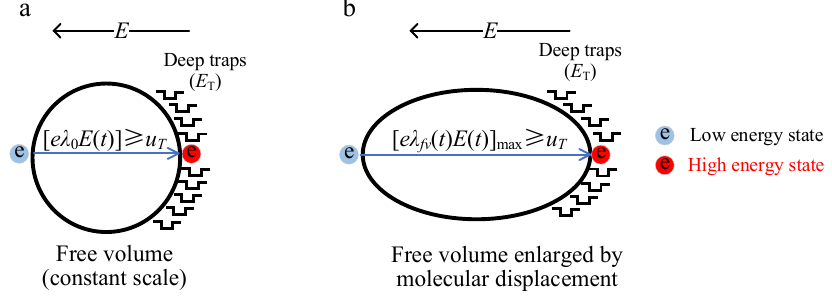
Figure 2. Electrical breakdown criteria of EBEG ( a ) and EBMD ( b ) models under a ramp